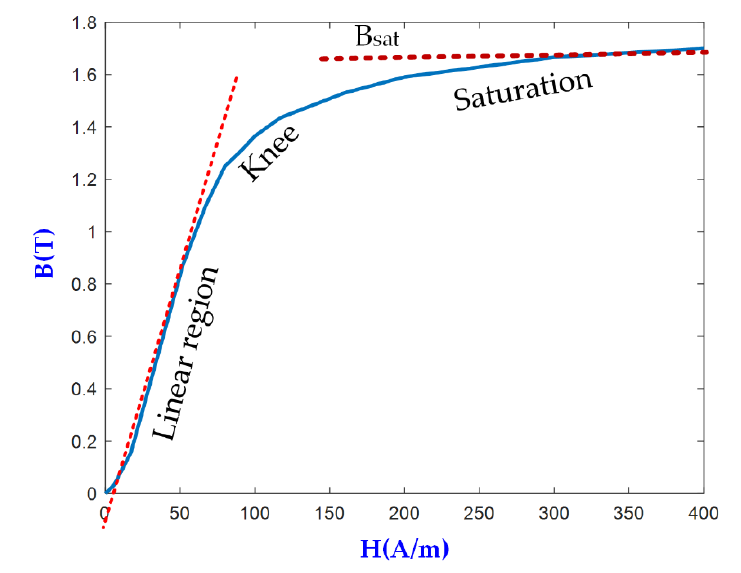
Figure 3. Magnetization curve of the non–linear inductor.